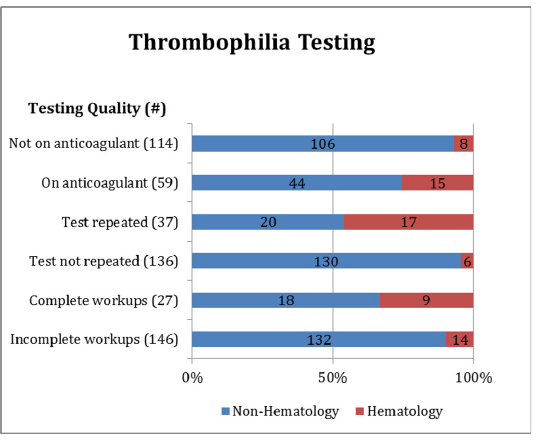
Fig 1. Characteristics of Ordering Practices Prior to Implementation of Guidelines.